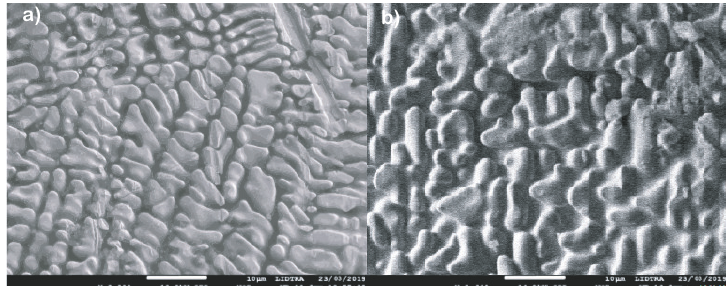
Figure 2. SEM image of biphasic composition of the tin and lead alloy taken at 2000 × . ( a ) corresponds SnPb alloy. ( b ) corresponds SnAg alloy. ( a ) shows a dentric structure Sn base, secondary phase flat with microparticles precipitated in the dentric surface of the base of Pb. Spherical particles are